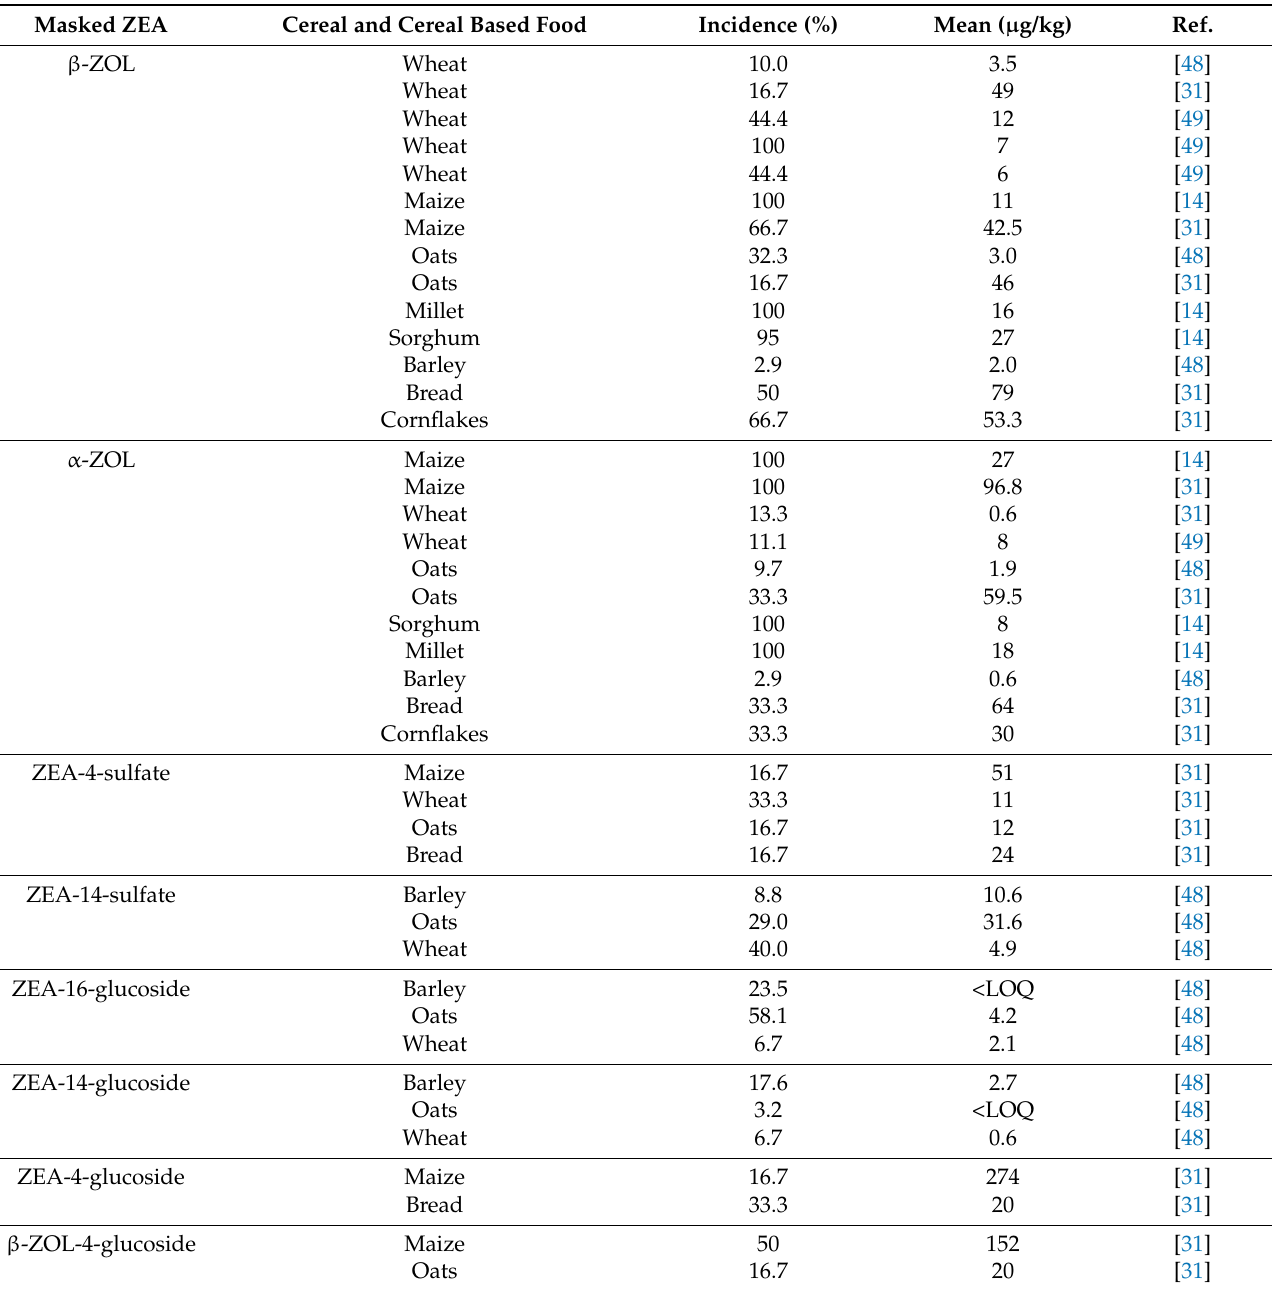
Table 1. Occurrence of masked ZEA in cereals and cereal-based